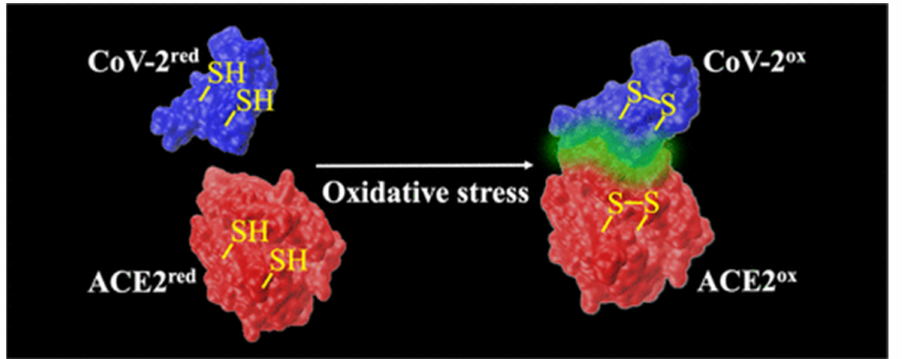
Figure 7. Disulfide bond forming on COVID-19 spike protein and ACE2 during oxidative stress. Both ACE2 and CoV-2 possess four disulfide bridges, equaling 8 cysteine residues. Source: [82].